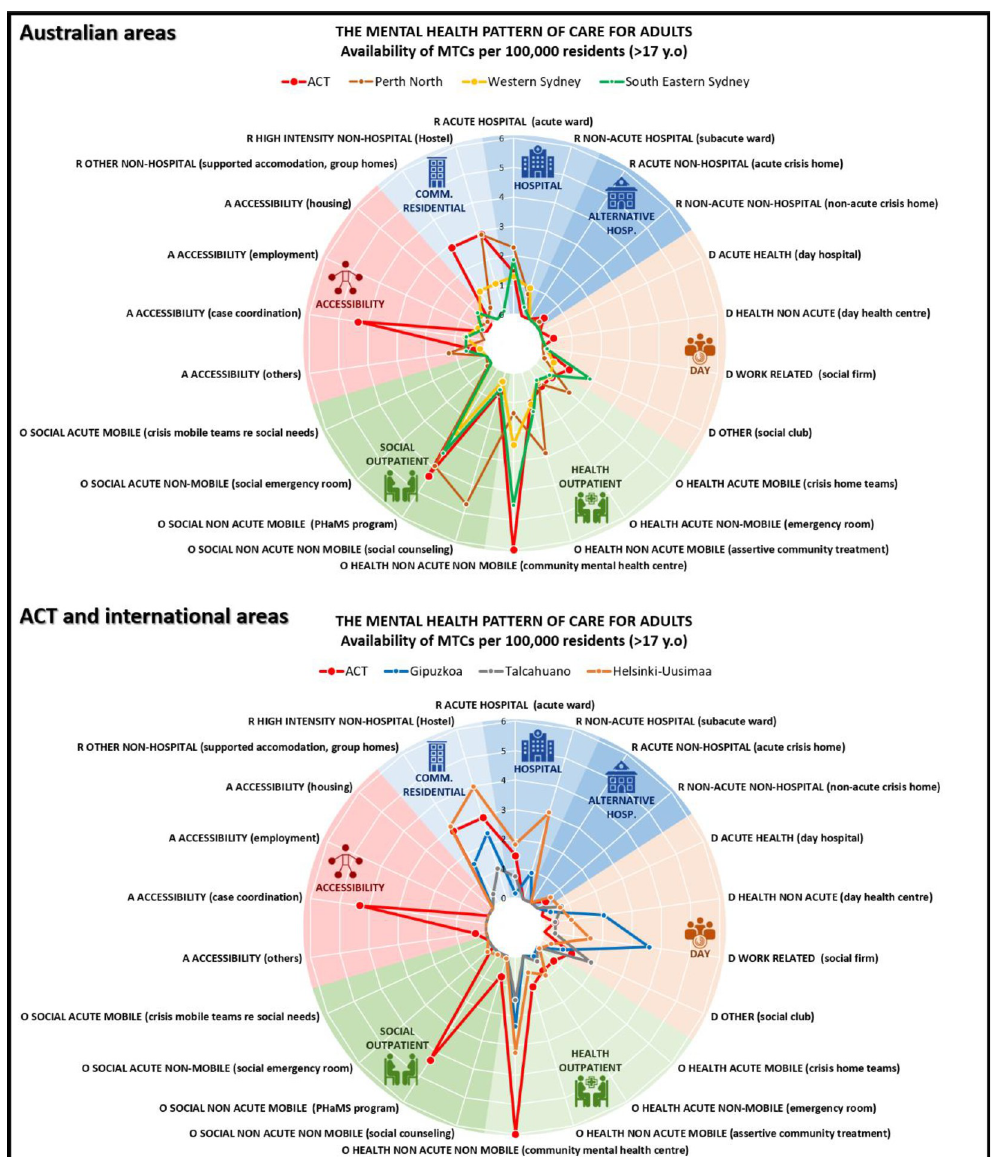
Fig 1. Main types of care per 100,000 adults: Australian and international comparison. Coloured sections of each radar graph represent the main branches of care, with each axis representing a main type of care within each of these branches. Coloured lines representing each region join the points on each axis showing the rates per 100,000 adults of that type of care for that region.